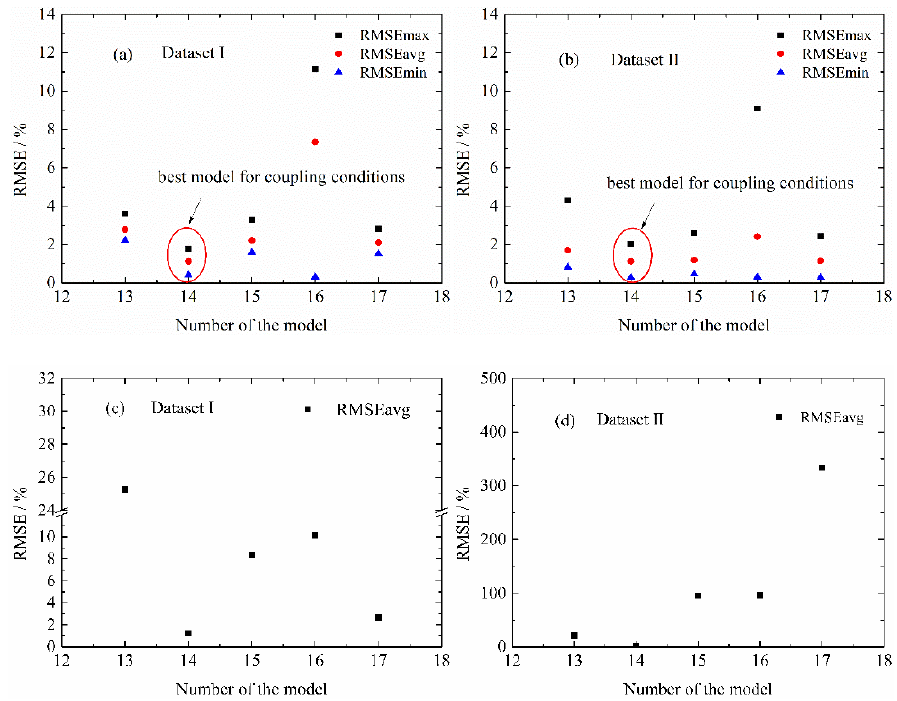
Figure 6. Prediction RMSE of the coupling-factor models for normal aging: ( a ) on the train dataset of Dataset Ⅰ, ( b ) on the train dataset of Dataset Ⅱ, ( c ) on the test dataset of Dataset Ⅰ and ( d ) on the test dataset of Dataset Ⅱ .